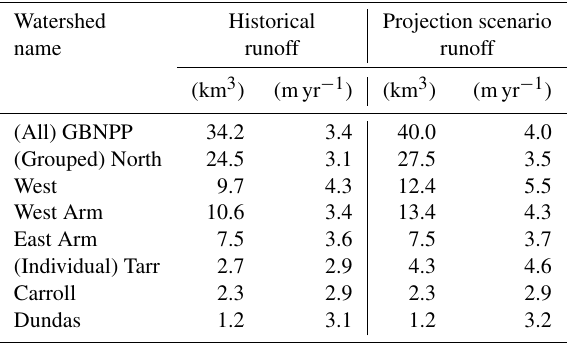
Table 3. Historical (1979–2015) and projection scenario (RCP 8.5; 2070–2099) runoff in cubic kilometers (km 3 ) and meters per year (myr − 1 ) for all